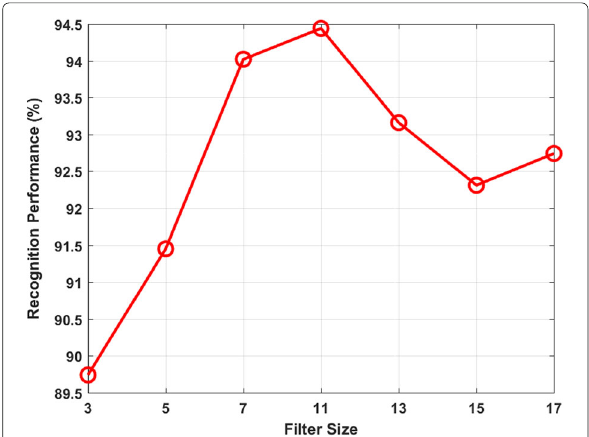
Fig. 3 Effect of filter size on ICANet: Assuming that the filter sizes for both phases of the convolutional layer were equal, the size range gradually increased from 3 ∼ 17. The results showed that ICANet had the best performance of the facial recognition systems when the filter size was